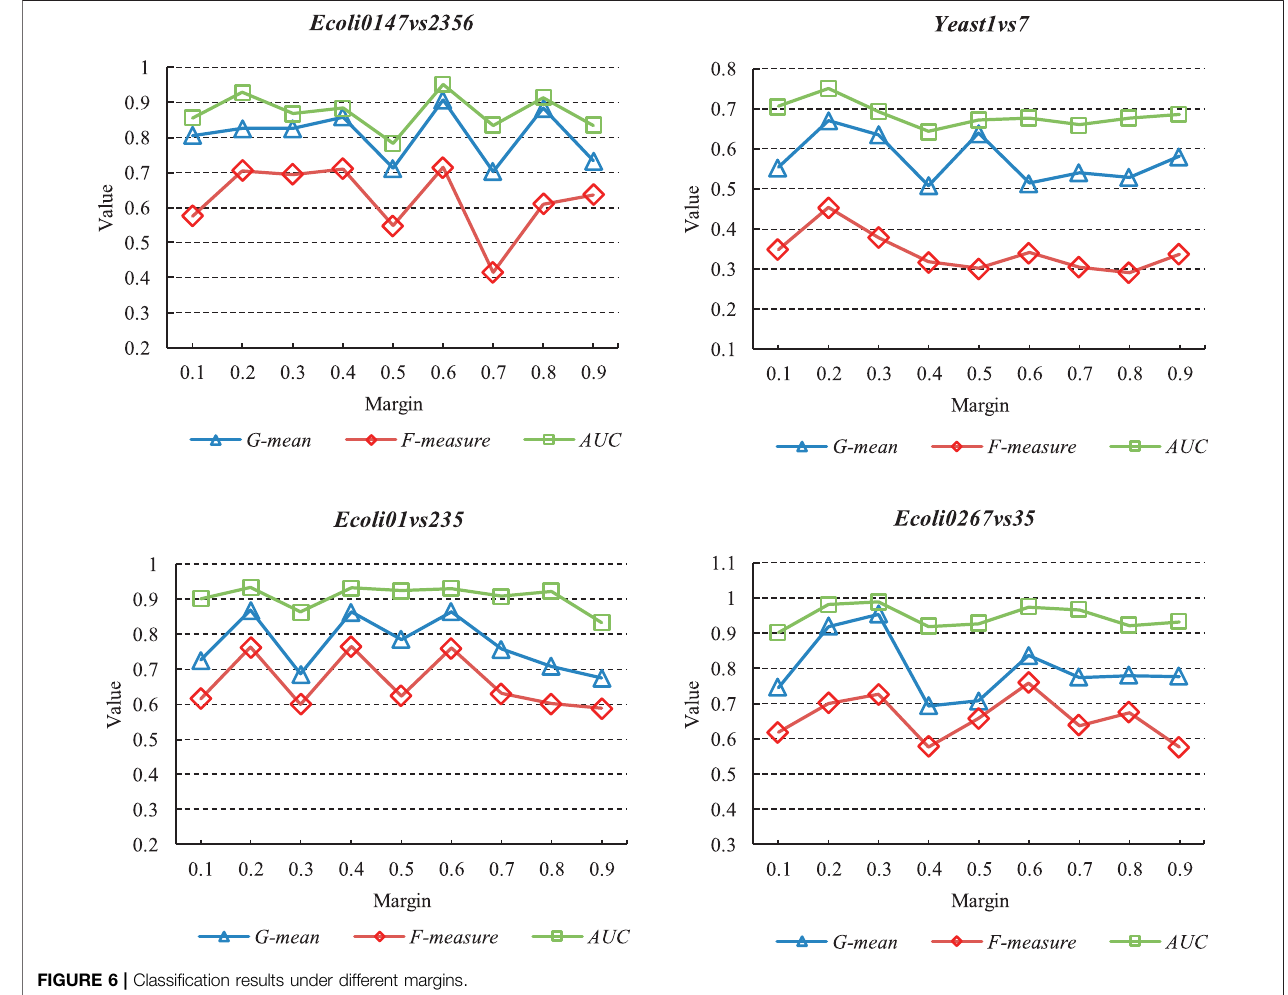
FIGURE 6 | Classi fi cation results under different margins.